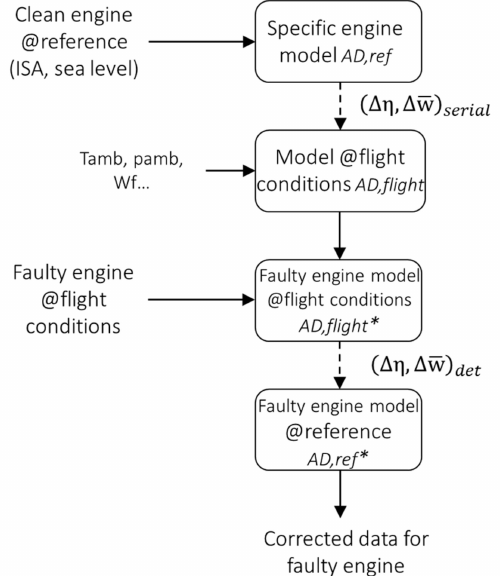
Figure 3. Flowchart of fault detection and data correction procedure with the adaptive